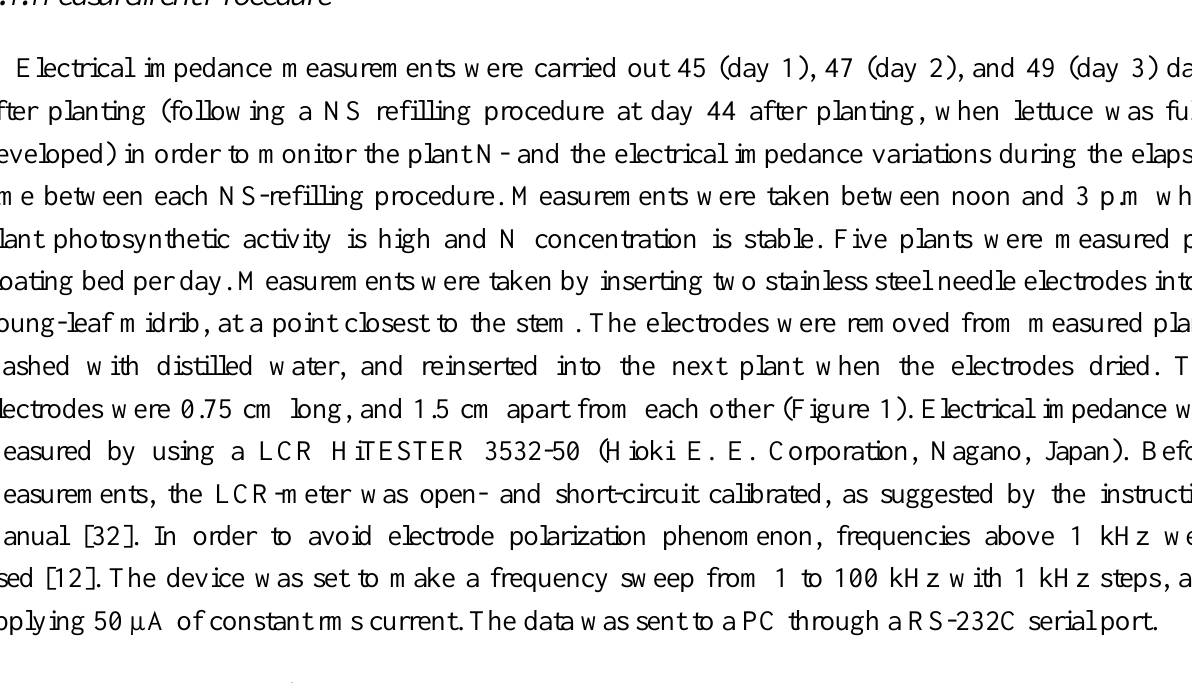
Figure 1. Electrical impedance measurement in